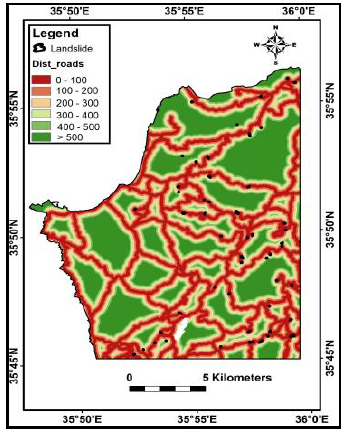
Figure 9. The distance map from roads extracted from the topographic map.